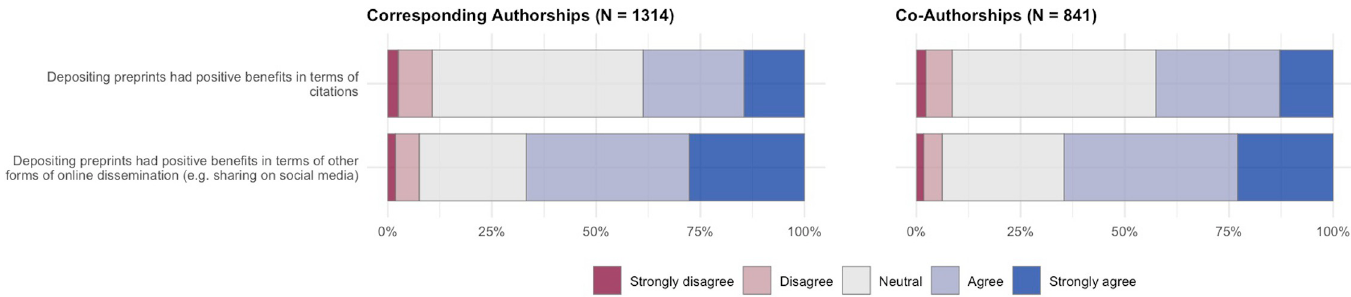
Fig 6. Benefits of posting preprints on article impact. Results show answers to survey questions on a 5-point Likert scale, divided by articles that authors published as a corresponding author (left) and articles that authors published as a co-author (right).